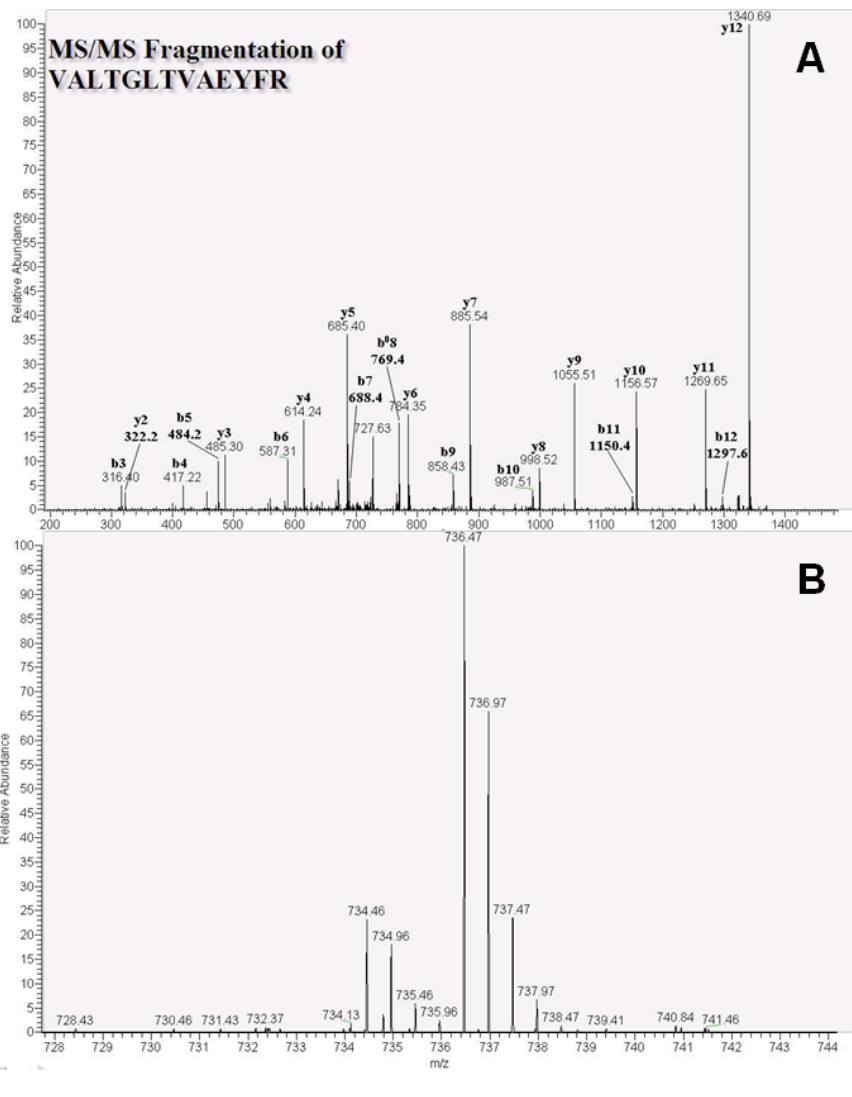
Figure 2. Nano-LC tandem MS spectra of the ATP synthase subunit beta protein peptide VALTGLTVAEYFR in MDA-MB-231 cells. ( A ) Product ion scan spectra of